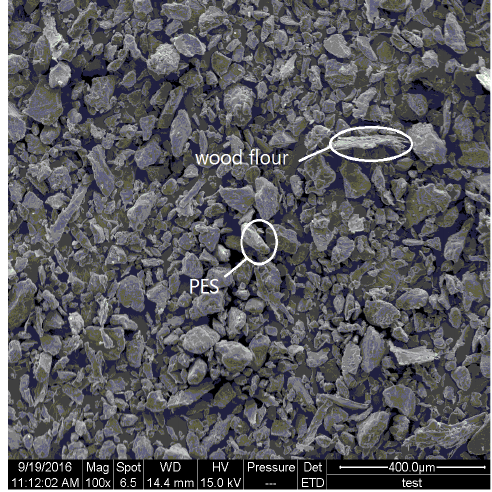
Figure 2. SEM image of the composite powder of wood flour, PES, and 0.1% CNTs.